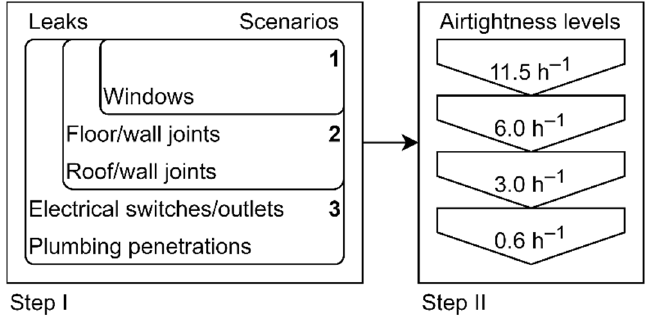
Figure 2. Plan considered for simulation.